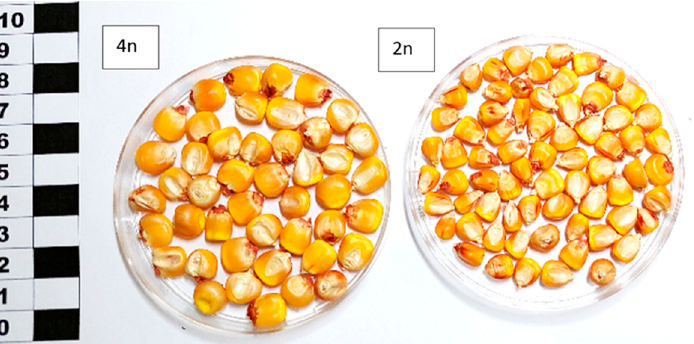
Figure 2. The grain size of tetraploid maize variety Population MRPP22 (4 n ) compared with diploid maize variety Luch (2 n ).